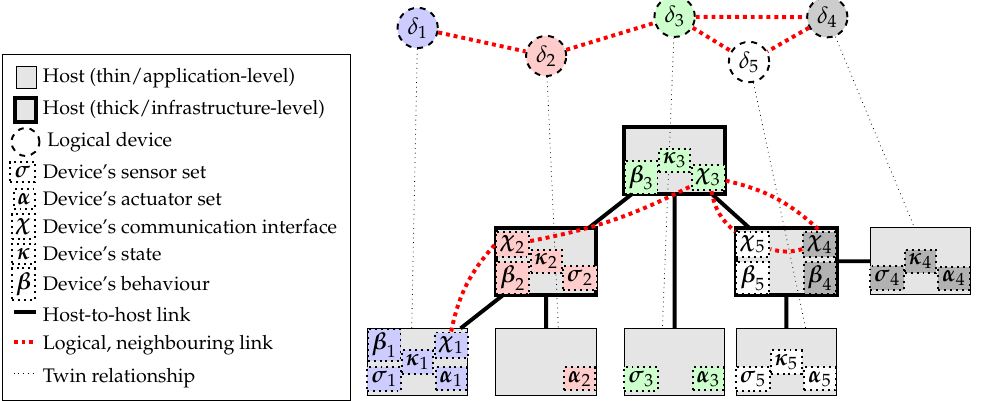
Figure 4. A view of an instance of the extended pulverisation architectural meta-model. The image shows the correspondence between the logical system ( top ) and its actual physical deployment, over an infrastructure enriched with support nodes (e.g., fog devices, edge servers, or cloud service providers). Different colours are associated with different logical devices: in some cases, components (dotted boxes) of a single logical device (dotted circle) are spread across multiple physical nodes (solid boxes), as intra-logical-device connections (not shown here, refer to Figure 3) are allowed to cross the host boundaries. Logical inter-device connections are represented with thick dotted red